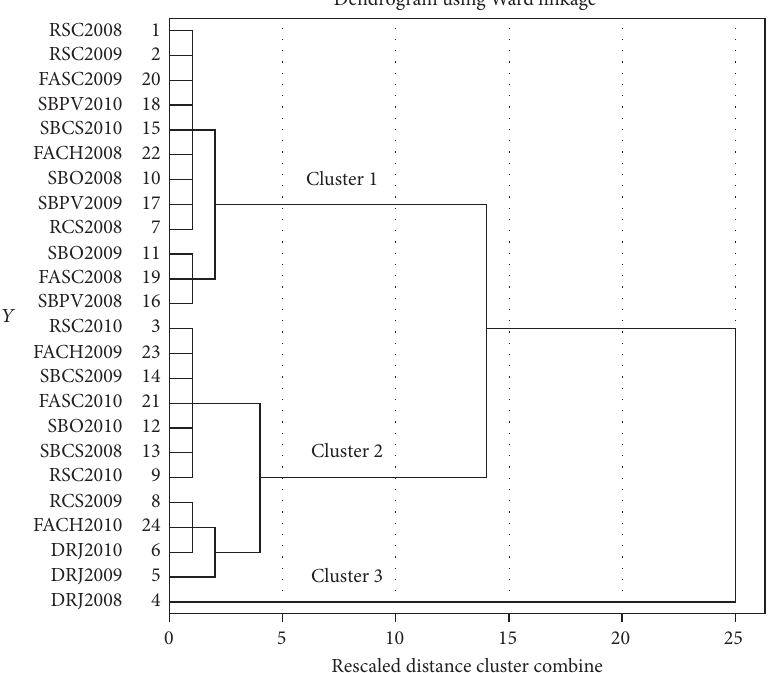
Figure 1: The obtained dendrogram of CLU analysis using Ward’s method.